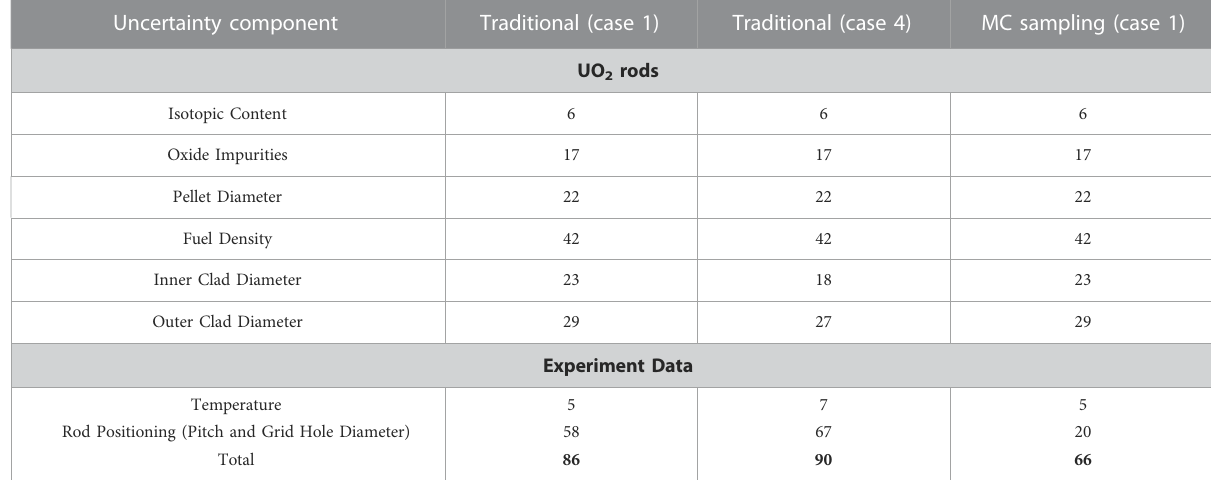
TABLE 5 Comparison of 1 σ Uncertainties (in pcm) for LEU-COMP-THERM-071 using Two